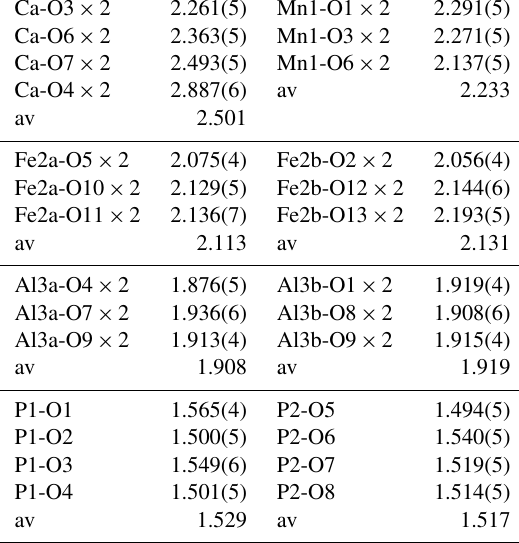
Table 5. Polyhedral bond lengths [Å] for